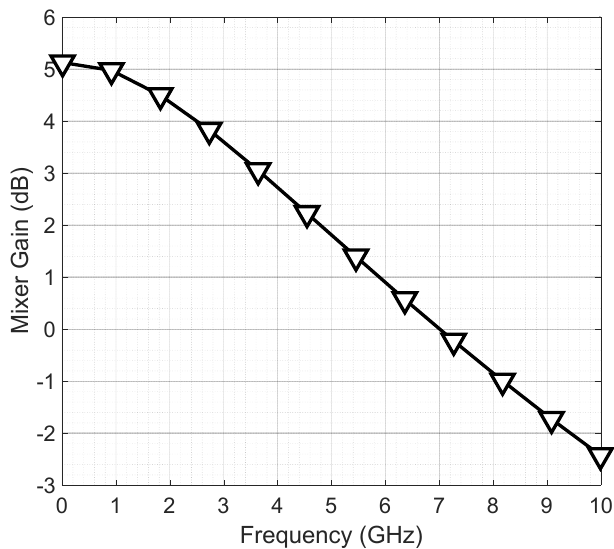
Figure 14. Simulated conversion gain of the implemented